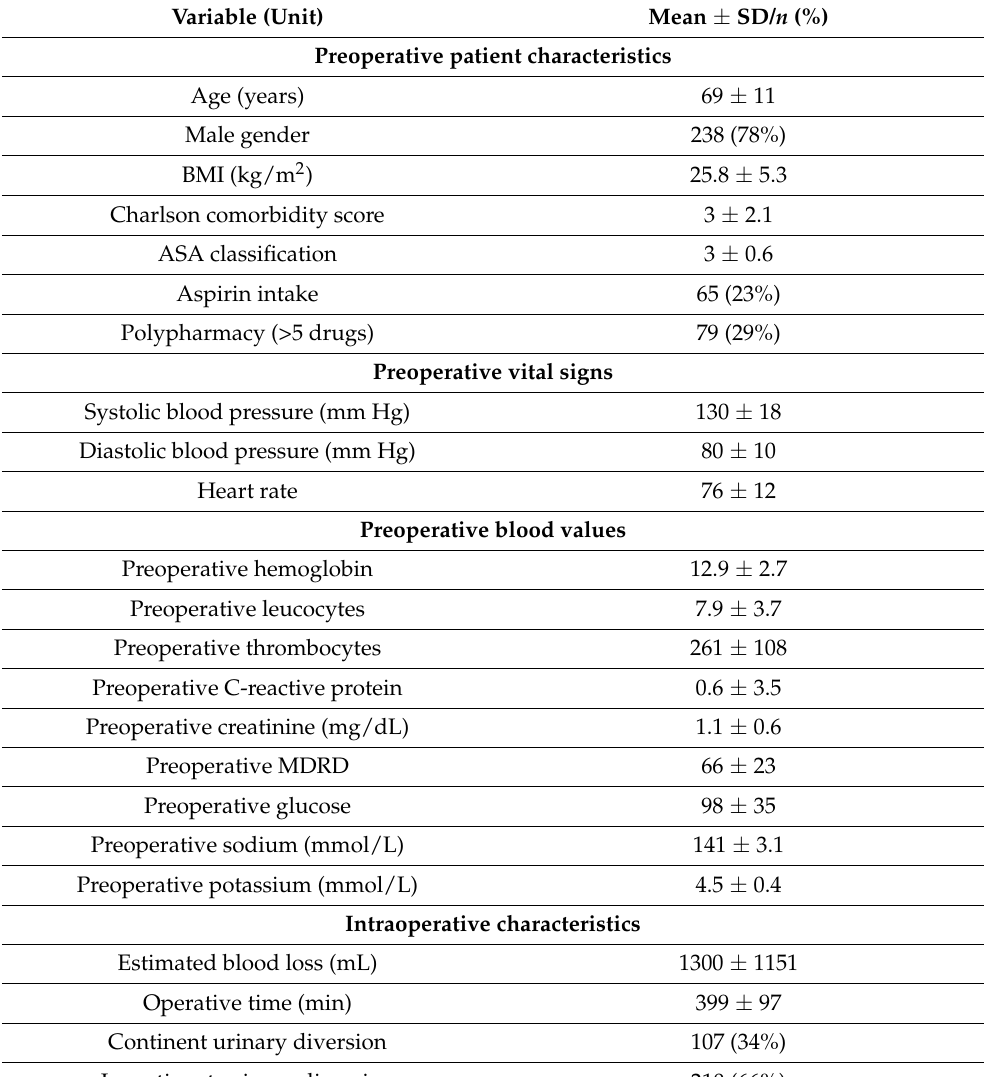
Table 1. Preoperative, intraoperative and postoperative characteristics of the 317 patients who underwent radical